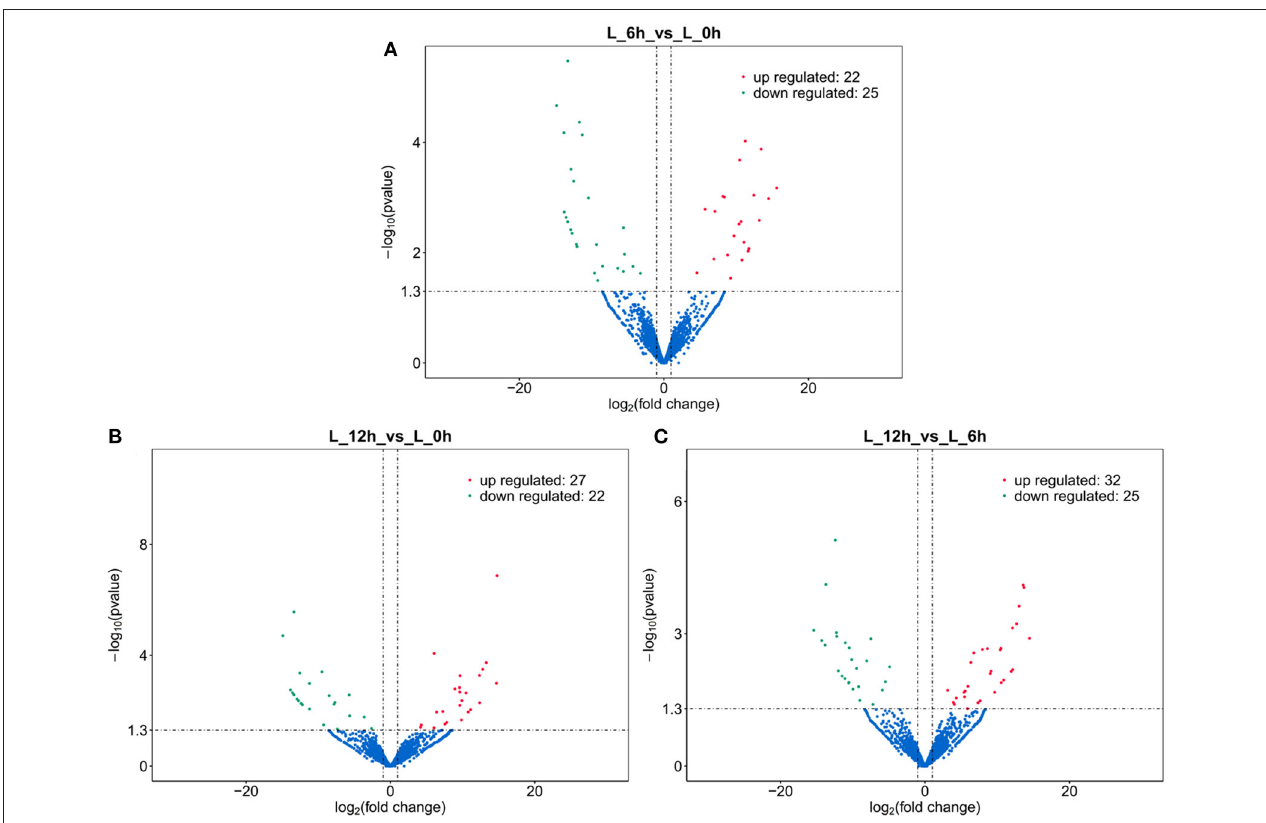
FIGURE 3 | Volcano plot of DElncRNA. (A) 6 hpi vs. 0h. (B) 12 hpi vs. 0h. (C) 12 hpi vs. 6